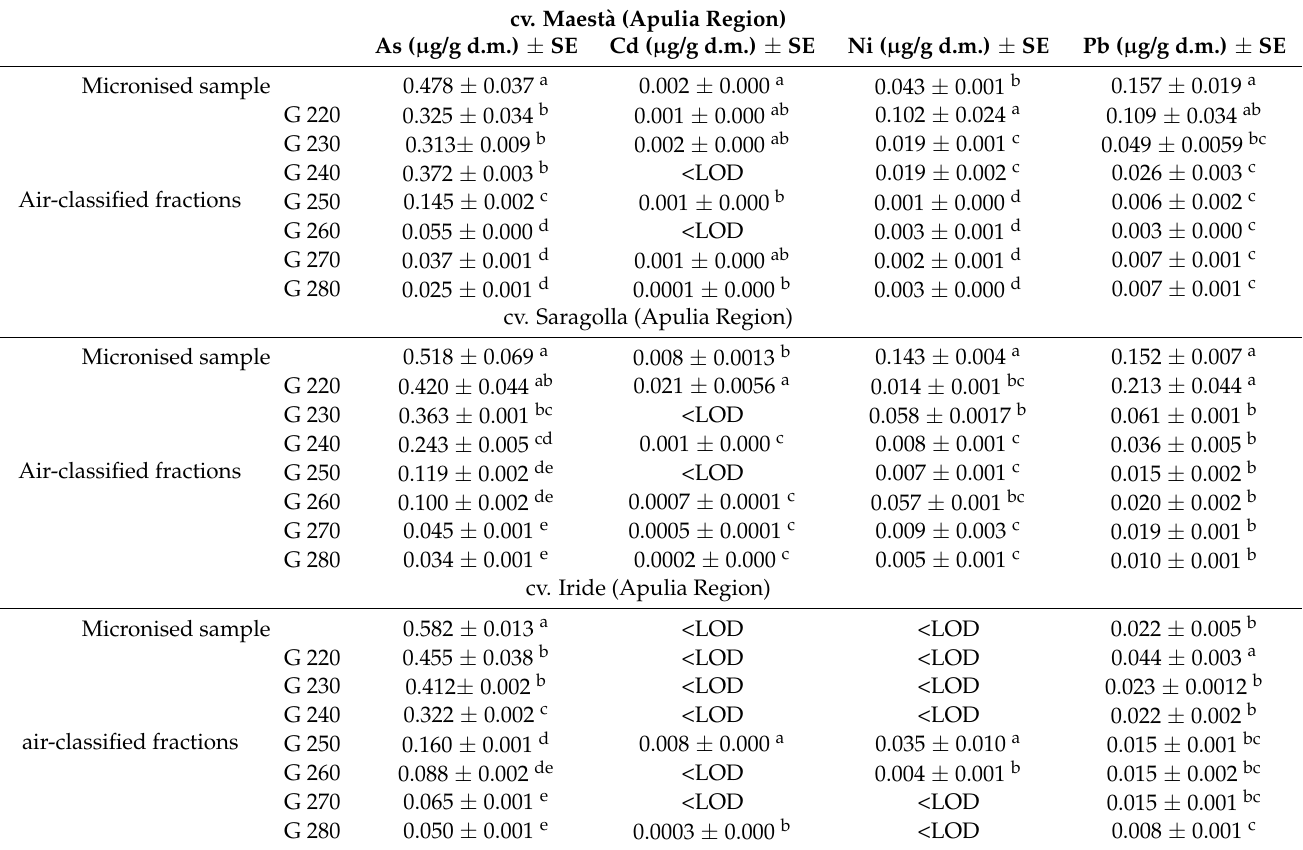
Table 2. Group I: average values ± standard error (SE) of arsenic (As), cadmium (Cd), nickel (Ni), and lead (Pb) contents in the micronised samples and G-type air-classified fractions; d.m.: dry matter; LOD: limit of detection , different letters indicate significant difference ( p < 0.05 ), n =